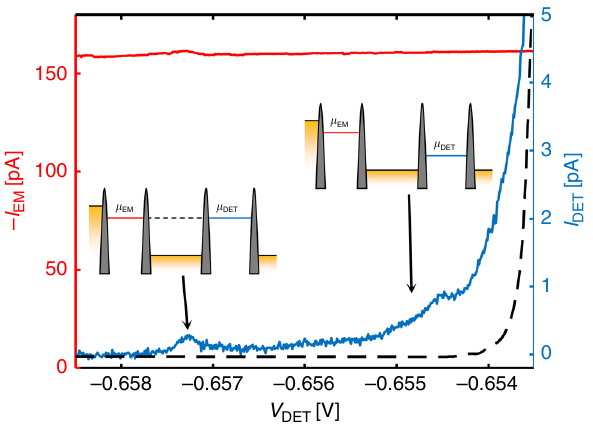
Fig. 2 Zero- fi eld electron transfer. Current through the Emitter (red) and Detector (blue) QD as a function of Detector plunger gate voltage in the absence of a perpendicular magnetic fi eld ( B = 0 T). The black dashed line indicates the background contribution of the Detector QD current due to an experimentally unavoidable slight misalignment between μ Res and μ Drain . The current through the Emitter QD stays constant for varying Detector QD chemical potential. The current through the Emitter QD shows both elastic and inelastic contributions. The insets show the schematic level alignment of the respective con fi gurations The black dashed line shows the current through the Detector QD in the absence of a current through the Emitter QD. It corresponds to the background contribution of the Detector QD current due to an experimentally unavoidable slight misalignment between μ Res and μ Drain . Here, the Emitter electrochemical potential is kept constant inside the bias window, i.e., the emission energy of the electrons ( μ EM ) is fi xed, only μ DET is varied. The current through the Emitter QD stays roughly constant as a function of Detector QD plunger gate. This is expected due to the small cross-capacitive coupling between Detector and Emitter QD.